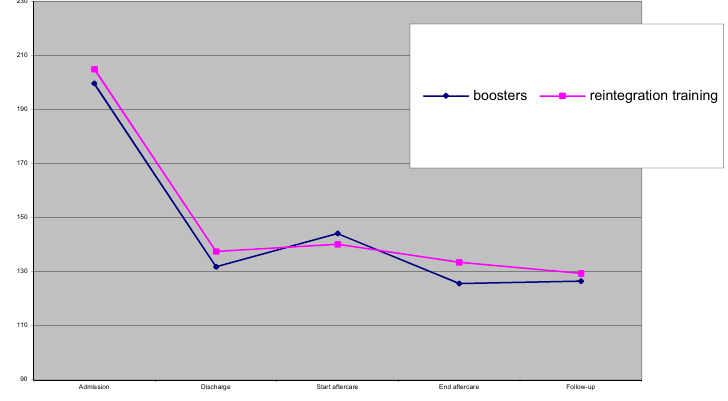
Figure 2: Numbers with paid job